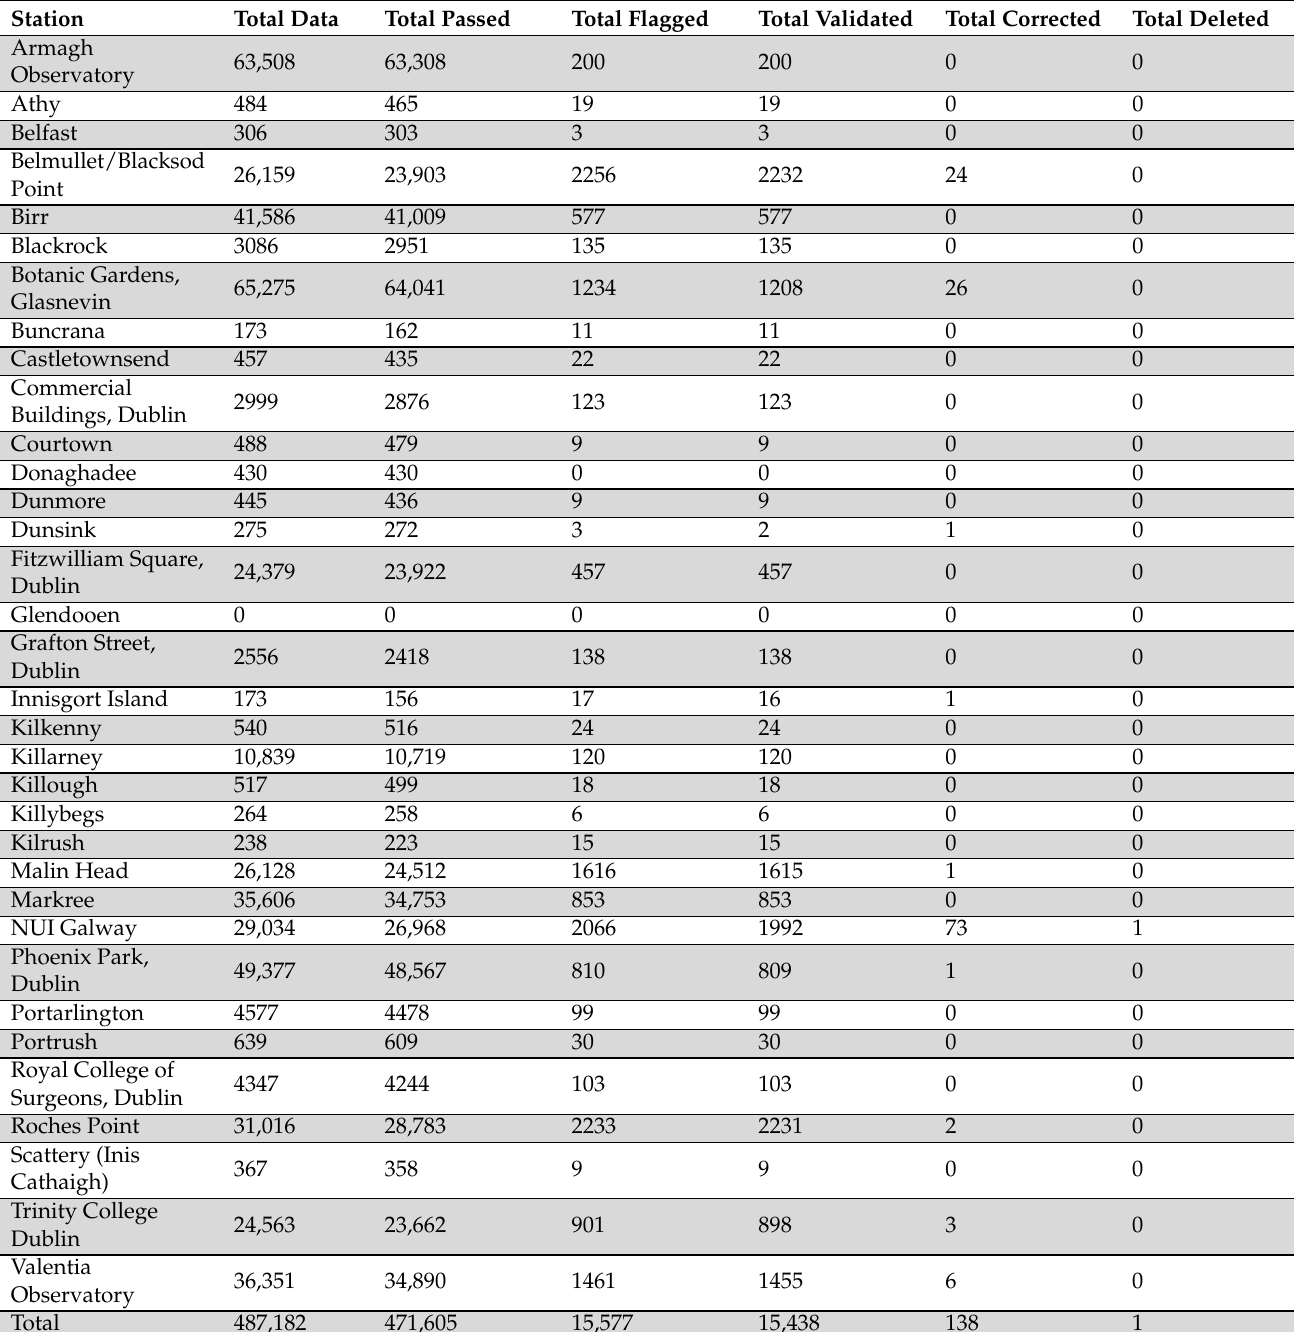
Table A9. Total of MAX data that failed the quality control test flag 10 and total validated, corrected and deleted